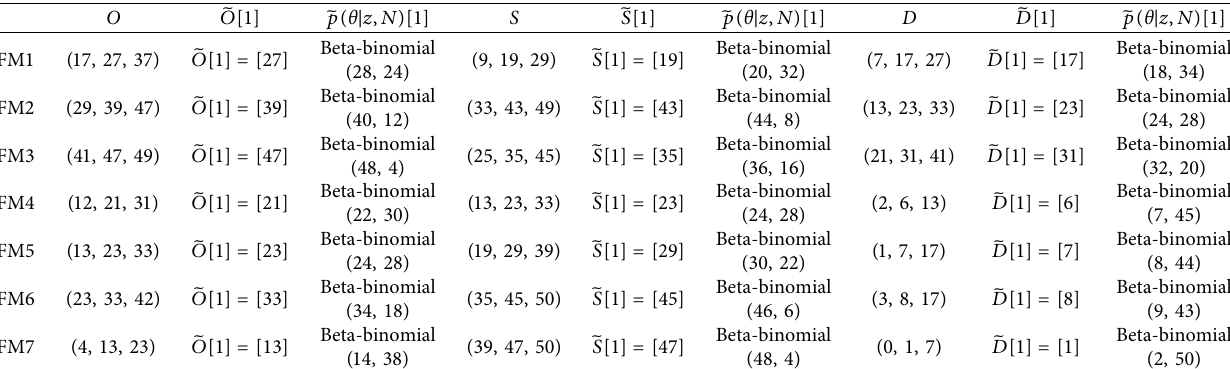
Table 6: The fuzzy beta-binomial distribution with α �